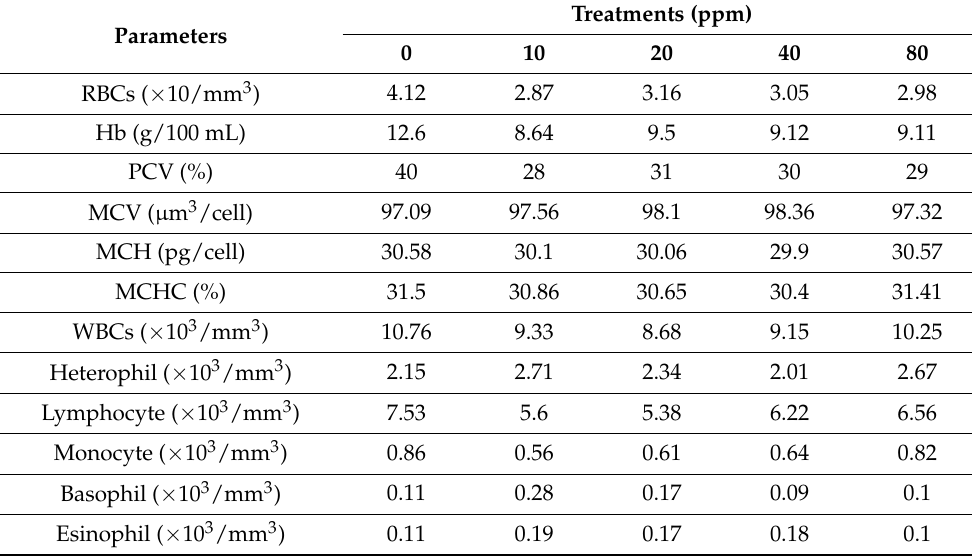
Table 7. Hematological parameters of the Nile tilapia , O. niloticus exposed to different concentrations of biosynthesized Hi -ZnO-NPs.